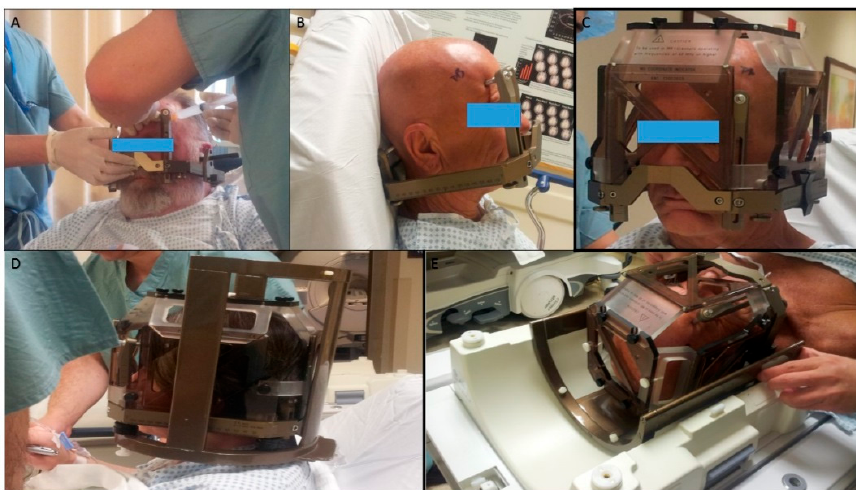
Figure 1. Different steps of Leksell frame application. ( A ) Application of the frame with the ear bars; note that the assistant is holding the frame in position with a lateral bar parallel to the intercommissural line while the senior surgeon is injecting a local anesthetic at the site of pin fixation; ( B ) position of the frame after its application; ( C ) the magnetic resonance imaging (MRI) localizer attached to the frame base; ( D ) the MRI localizer and the table adaptor attached to the frame base; ( E ) the table adaptor fitting to the MRI table.